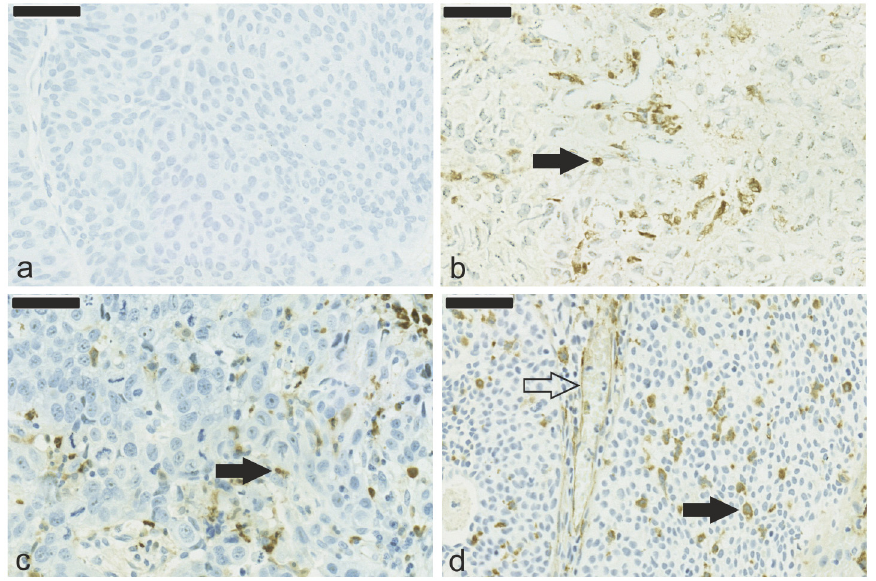
Fig 1. Immunohistological detection of macrophages in bladder cancer. TUR-BT specimens stained with a negative control antibody (a); intratumoral CD68 + macrophages (b), MAC387 + macrophages (c), and CLEVER-1/Stabilin-1 + macrophages and vessels (d). Filled arrows indicate positively stained macrophages, and unfilled arrows indicate CLEVER-1/Stabilin-1 + vessels. Magnification 40×, scale bar 100 μ